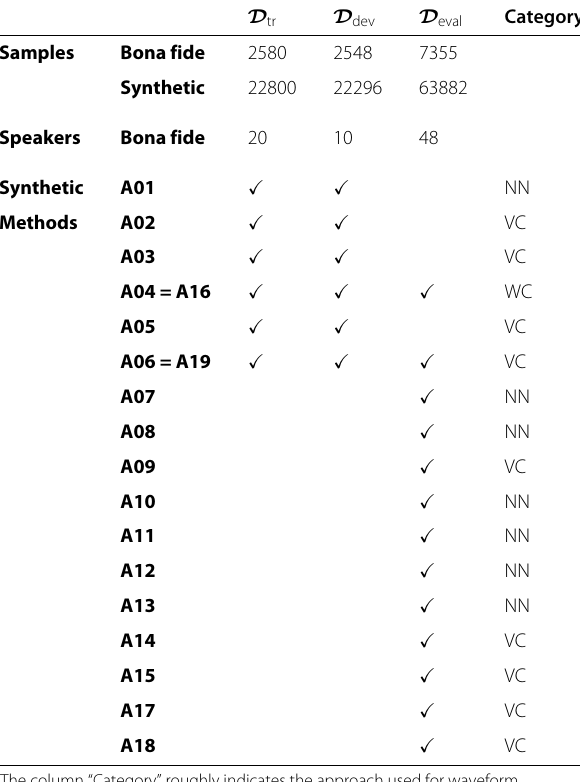
D D D tr dev eval Category